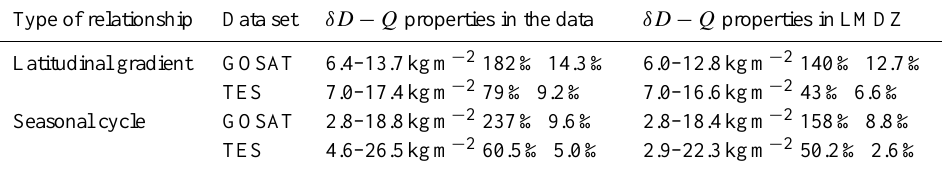
Table 3. Relationships between precipitable water ( Q ) and total column water vapor δD as observed by GOSAT or TES and as simulated by LMDZ. We show the relationships for the latitudinal transects as plotted in Fig. 4 and for seasonal cycles as plotted in Fig. 6. For each relationship, we give successively the Q range (minimum and maximum values, in kgm − 2 ), the δD range (maximum minus minimum values, in ‰, we do not give absolute values since they might be subject to calibration issues) and the slope of the δD -ln (Q) relationship (in ‰). The correlation coefficients for the δD -ln (Q) relationship are all between 0.82 and 0.84. When we compare LMDZ to GOSAT or TES, we collocate model outputs with each data set and apply the adequate averaging kernels.